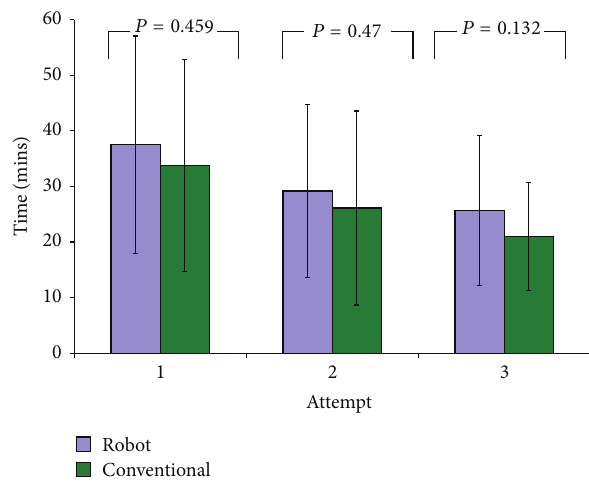
Figure 3: Bar graph showing the mean UKA procedure time at each attempt for the robot and conventional groups. 𝑃 values refer to intergroup analysis. Significant 𝑃 values are highlighted. Error bars = ± 2SD.